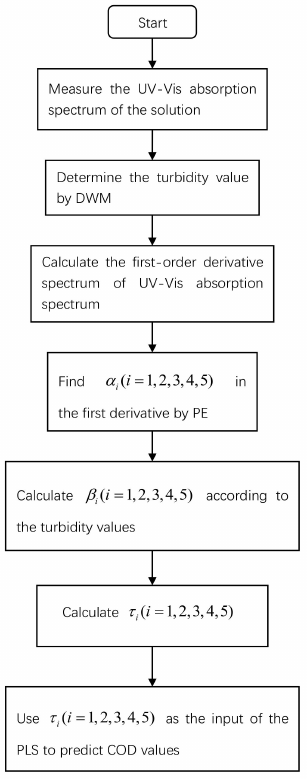
Figure 7. The flow chart of FDPE_PLS with turbidity